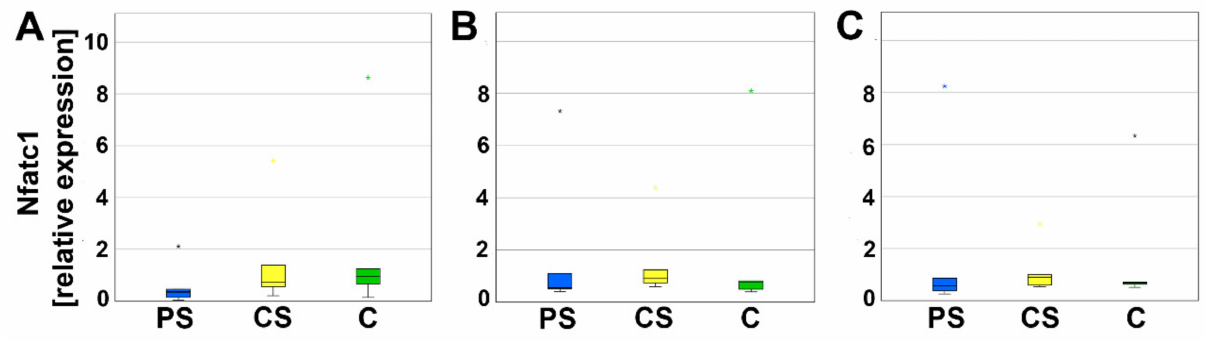
Figure 4. Relative expression of Nfatc1 after 4 ( A ), 8 ( B ), and 12 days ( C ). Small asterisks denote